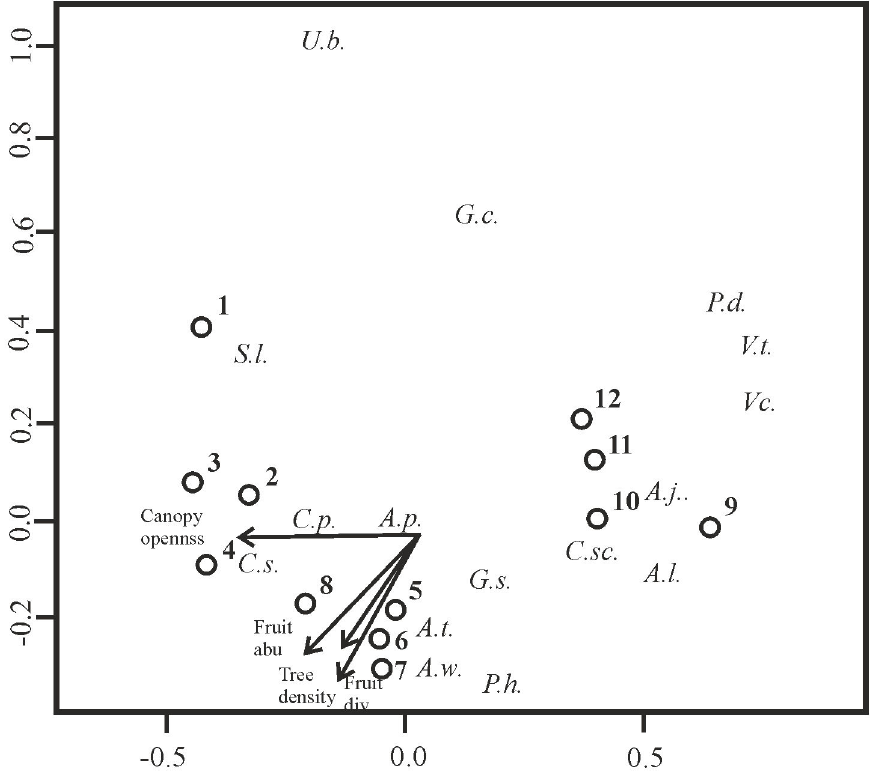
Figure 2. Non-metric multidimensional scaling (NMDS) ordination based on Bray-Curtis dissimilarity of frugivorous bat species abundance and the associated significant environmental variables. Sites: 1-4 O. pyramidale managed forests, 5-8 secondary forests and 9-12 rain forests. Directions of arrows indicate increasing variable value. Italic letters represent frugivorous bat species names, with 1st letter for genus and 2nd letter for species (exception: Centurio senex is C. sx ; see Table 1). doi: